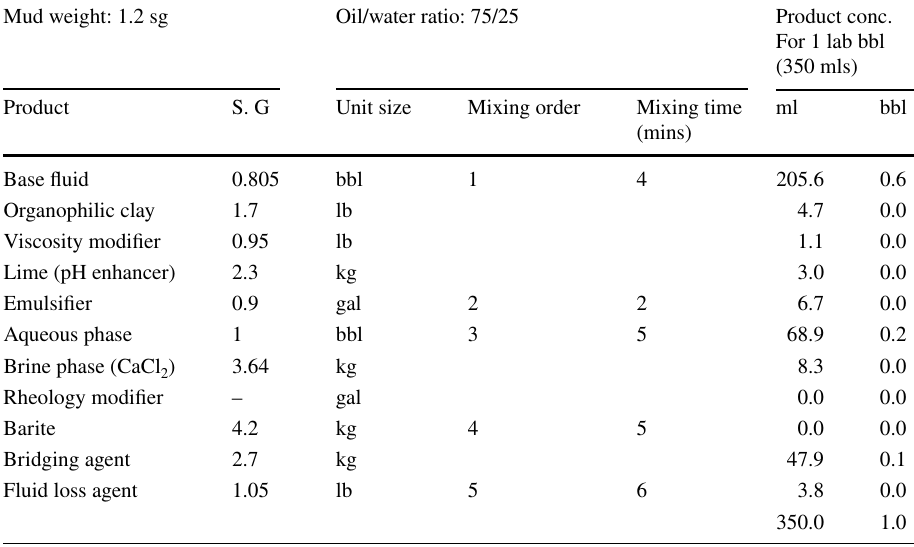
Table 3 Laboratory formulation for preparation of equivalent to one barrel of